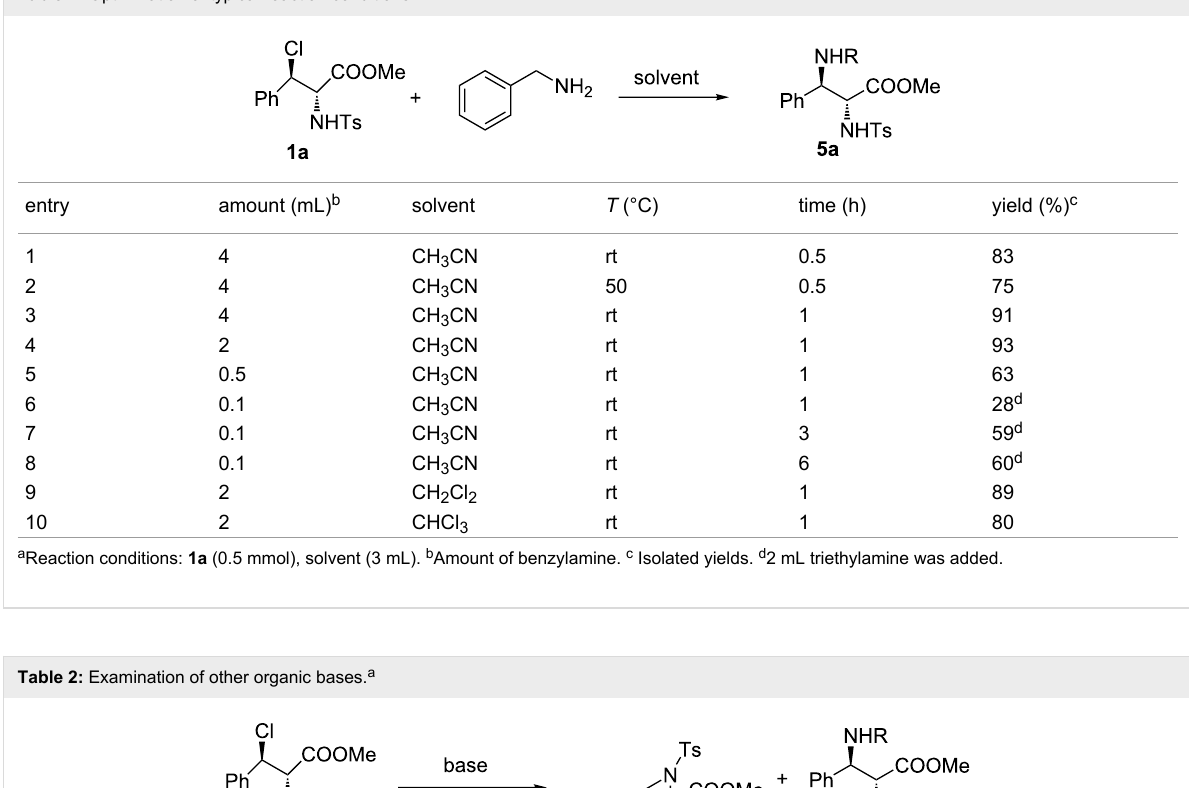
Table 1: Optimization of typical reaction conditions. a